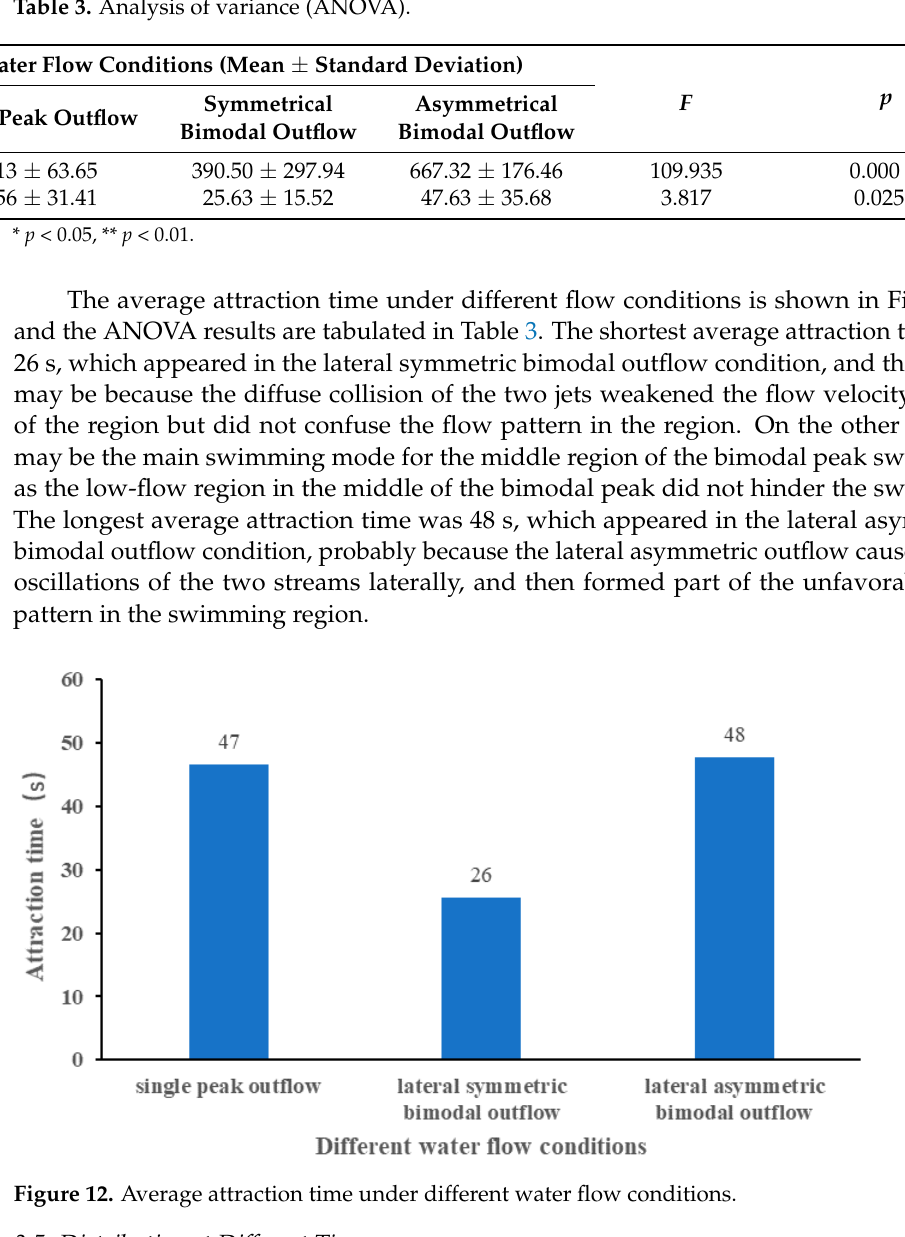
Table 3. Analysis of variance (ANOVA).